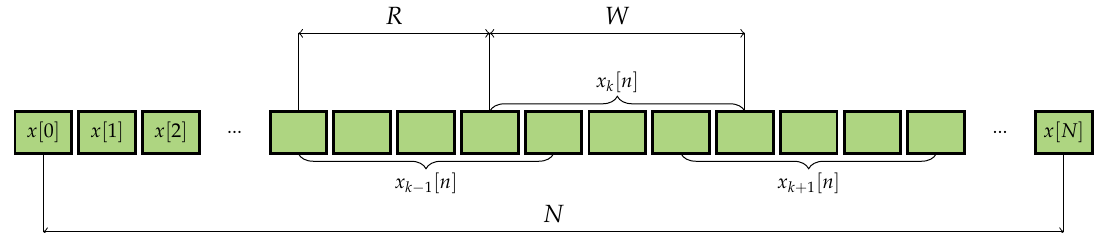
Figure 2. Sequence